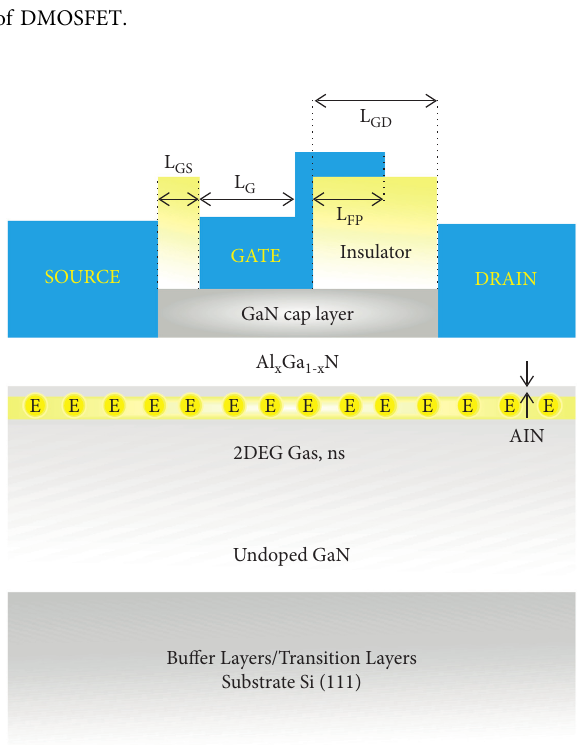
Figure 6: Cross section of a normally on Ga-N